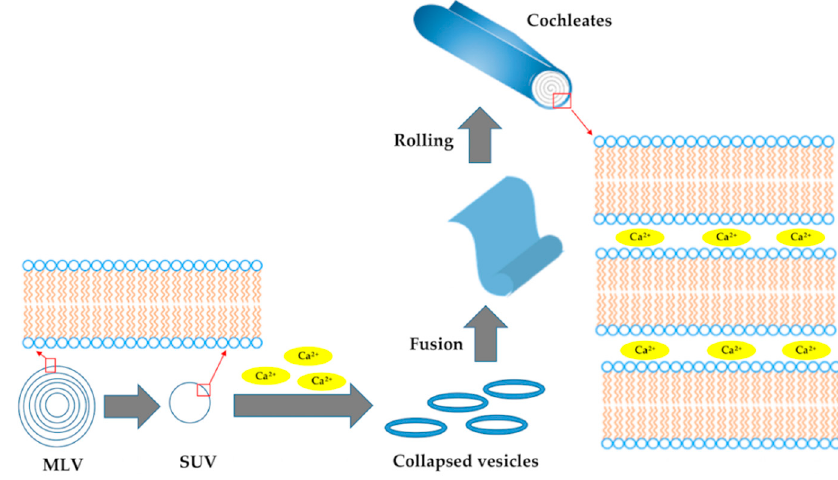
Figure 2. Multi-step preparation process of nanocochleates.